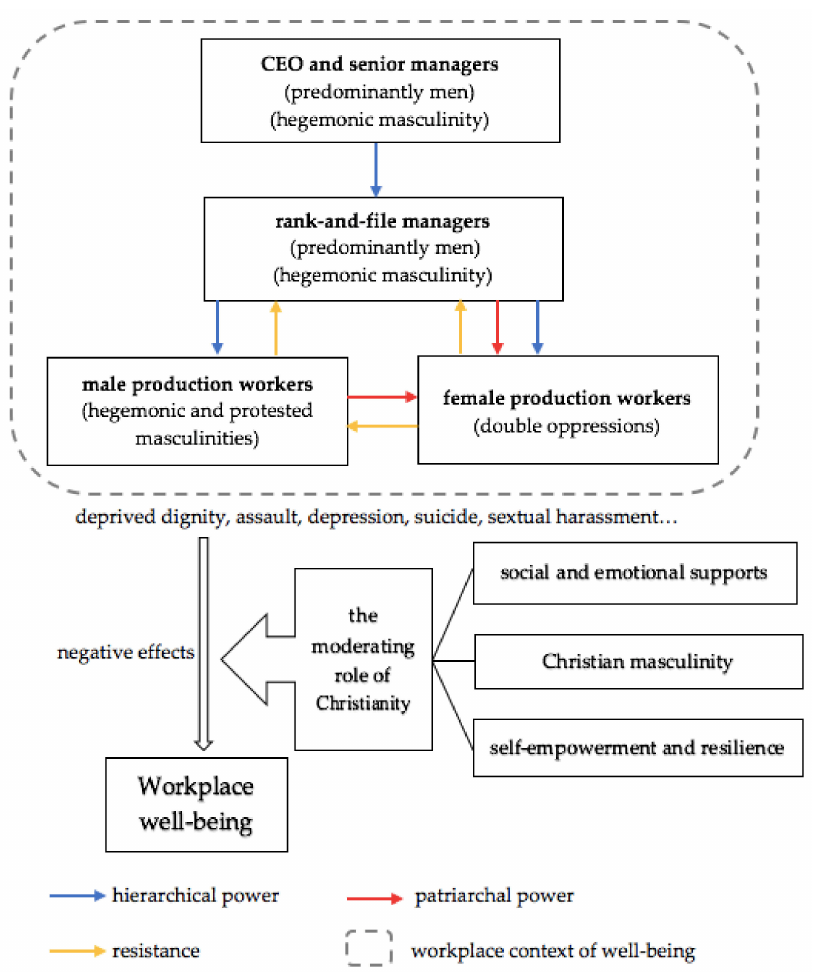
Figure 1. The model of masculinity, religion and workplace well-being. Note: CEO is the abbreviation of “Chief Executive